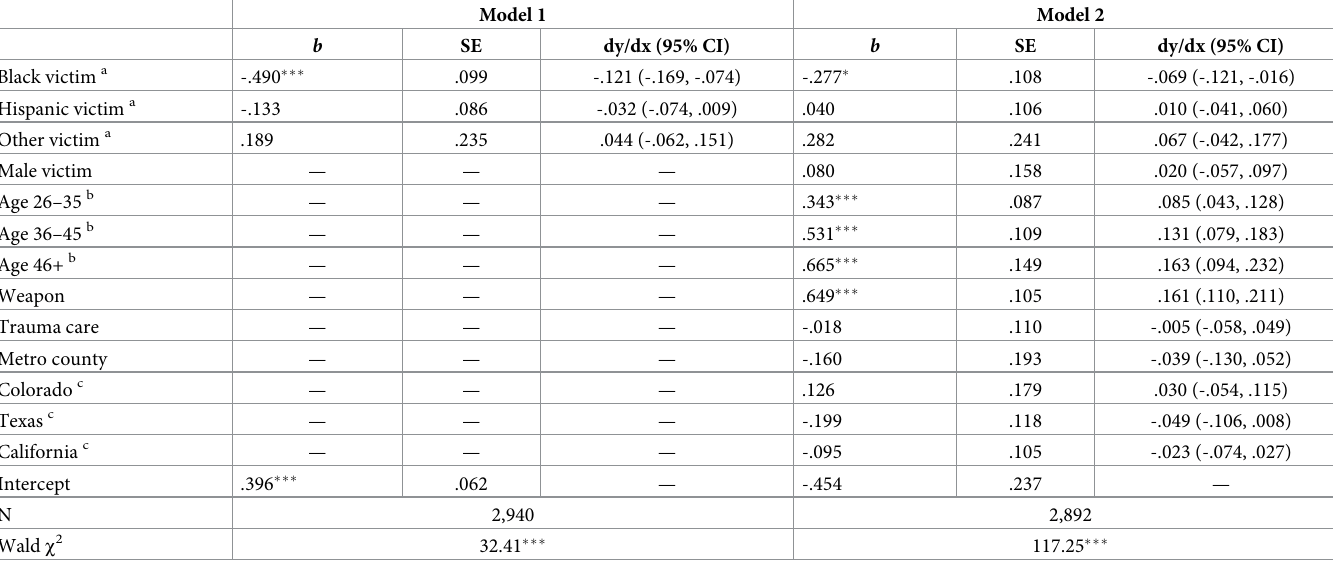
Table 1. Logistic regression models predicting the mortality of police shootings in the pooled